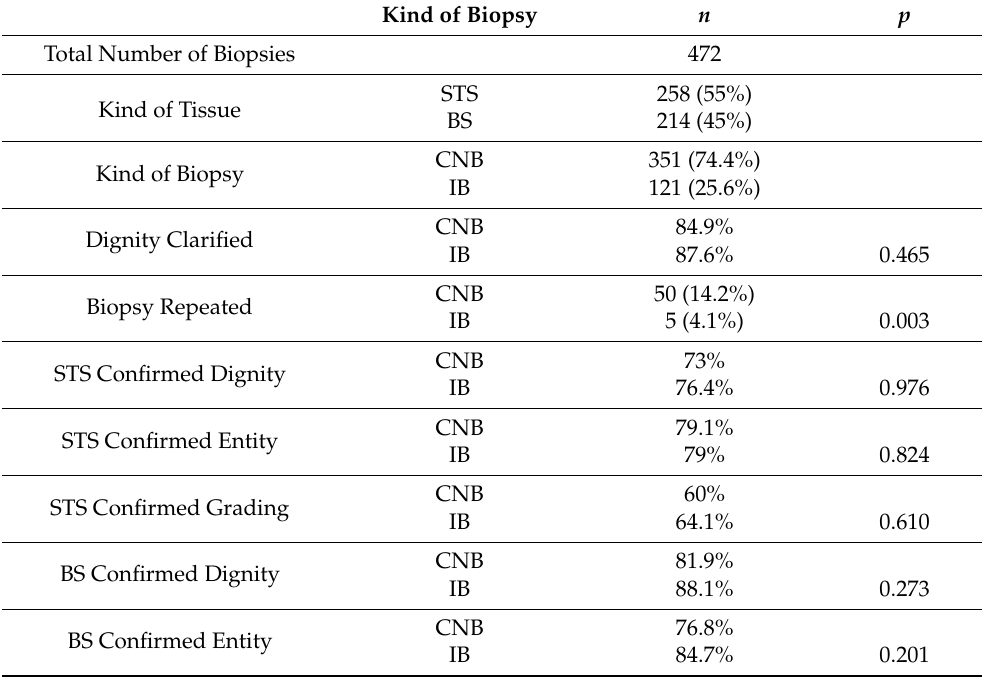
Table 2. Characteristics of biopsies and their result (STS: Soft tissue sarcoma; BS: Bone sarcoma; CNB: Core needle biopsy; IB: Incisional